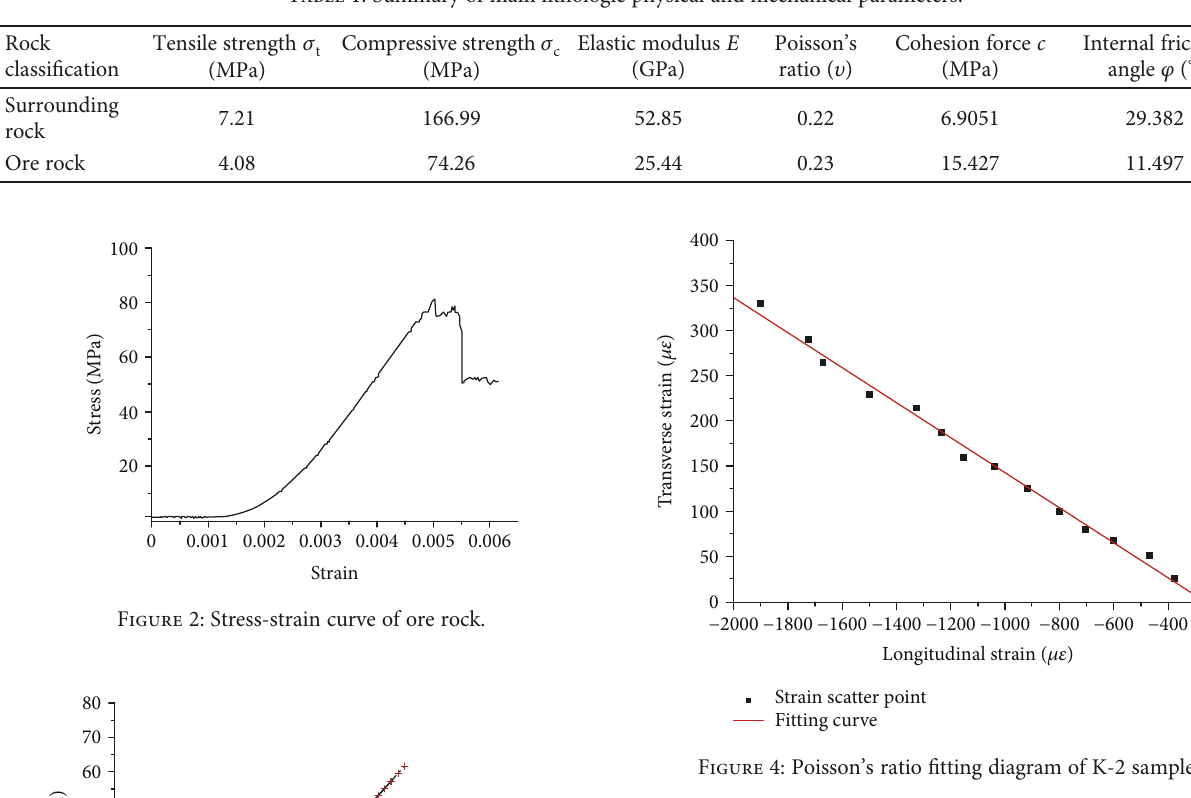
Table 1: Summary of main lithologic physical and mechanical parameters.